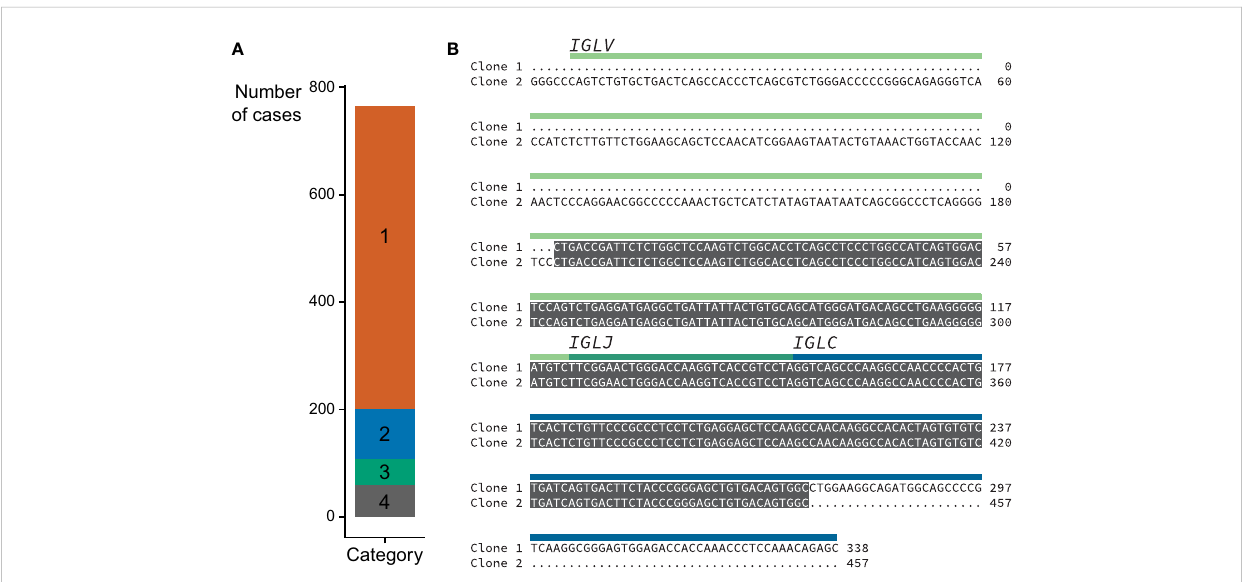
(Figure 7). There are four unique CDR3 nucleotide sequences